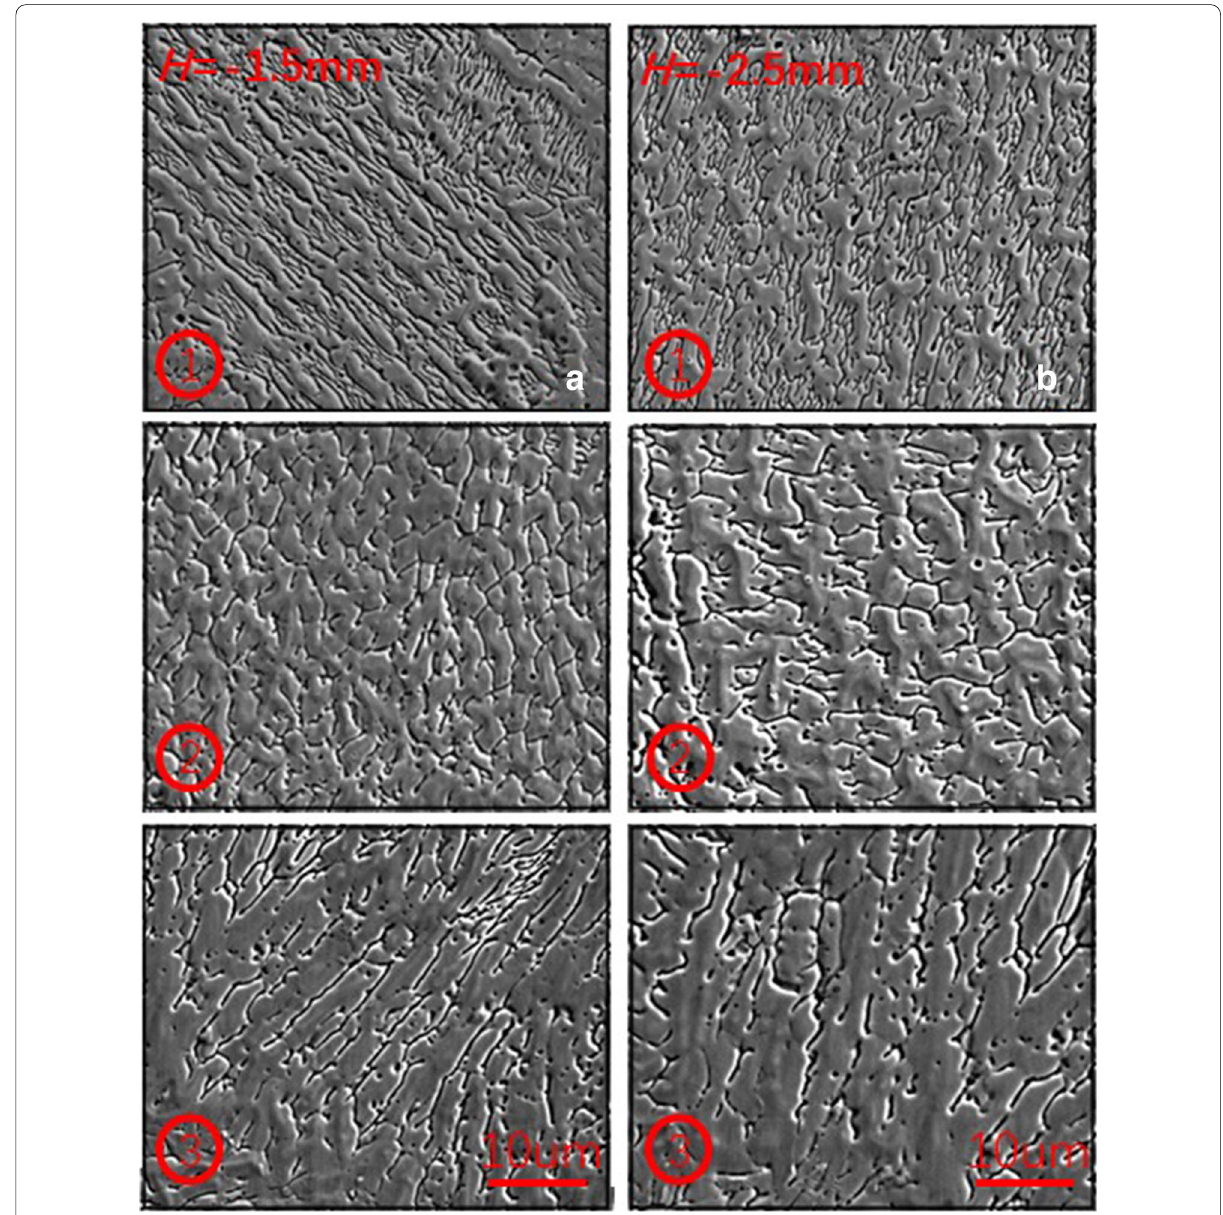
Figure 23 Microstructure at areas 1, 2, and 3 when defocus distances are a